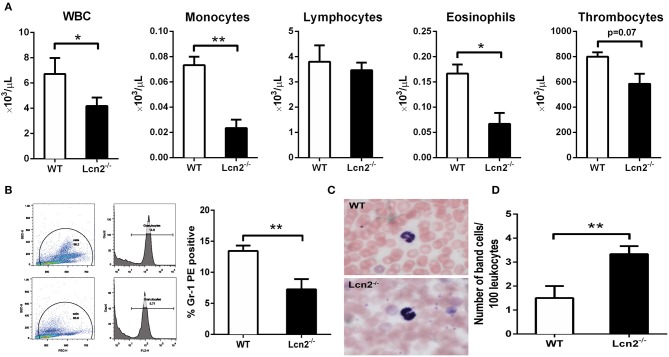
Granulocyte abnormalities in Lcn2−/− mice. (A) Hematological parameters of peripheral blood from wild-type (WT) and Lcn2−/− mice. The data are presented as mean × 103 cells/μl. Error bars depict SEM (n = 6 per group). (B) Flow cytometry analysis of neutrophils in the peripheral blood after intragastric administration with 2 × 108 CFU of E. coli O157:H7. Cells were stained with indicated clones of Gr-1 Ab, and positive cells were determined by flow cytometry. Values are average means of triplicate experiments with two mice per genotype per experiment. Error bars depict SEM. (C) Wright-Giemsa staining of peripheral blood smears from Lcn2−/− mice identified atypical hyposegmented neutrophils in the peripheral blood. Original magnification ×63. In contrast, WT mice displayed normal neutrophil maturation. (D) Enumeration of the number of band neutrophils in the peripheral blood of Lcn2−/− mice. The data are presented as mean band cell numbers per 100 leukocytes. Error bars depict SEM. Results are expressed as means ± SEM. P < 0.05 was considered statistically significant. *P < 0.05, and **P < 0.01.